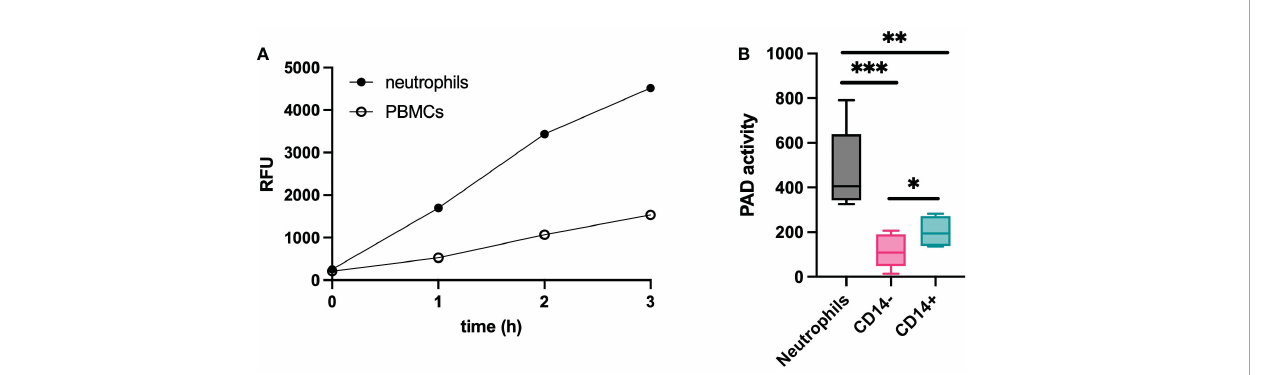
FIGURE 4 PAD activity in leukocytes. Lysates of leukocytes (1x10 6 cells) from healthy subjects (n=6) were used to determine the citrullinating capacity per cell type. Substrate conversion by PAD from neutrophils and PBMCs is expressed in relative fl uorescent units (RFU) and was monitored over time (A) . Further characterization was performed on neutrophils and PBMC-derived cells that were selected based on presence or absence of CD14 expression (B) . An Evans blue quencher concentration of 10.5 µM and a TAMRA-(GRGA) 4 substrate concentration of 0.5 µM were used. PAD activity in indicated as substrate conversion detected as change in relative fl uorescence units per minute ( D RFU/min). Error bars show min to max value, center values represent median value. Signi fi cance considered * for p<0.05, ** for p<0.01, *** for p<0.001 by unpaired